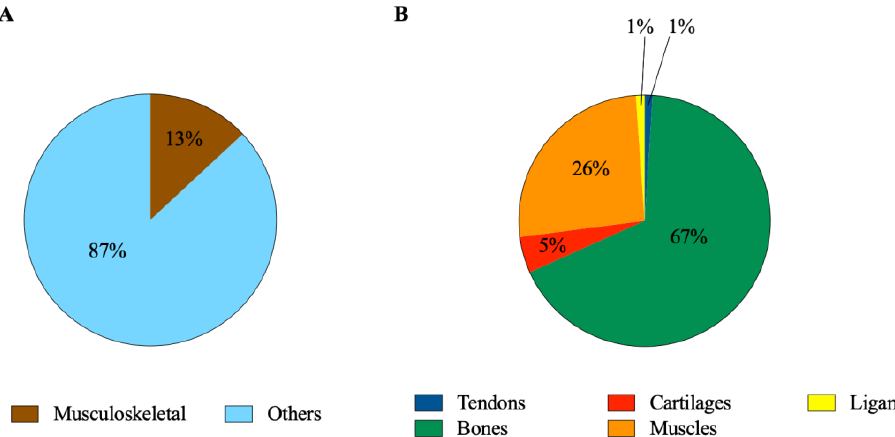
Figure 1. The comparative scientometric analysis of available publications on the Scopus database by using the terms “immunomodulation”, “immunomodulatory”, “immunoregenerative”, “immunoregeneration”, and “immunoengineering” reveals that: ( A ) only 13% of the total publications refer to the musculoskeletal tissues. ( B ) A deep analysis concerning the musculoskeletal tissues demonstrated that bones are the most studied tissue in this field (67%) followed by muscles (26%), cartilages (5%), and finally with the least publications number for tendons and ligaments with 1% each.